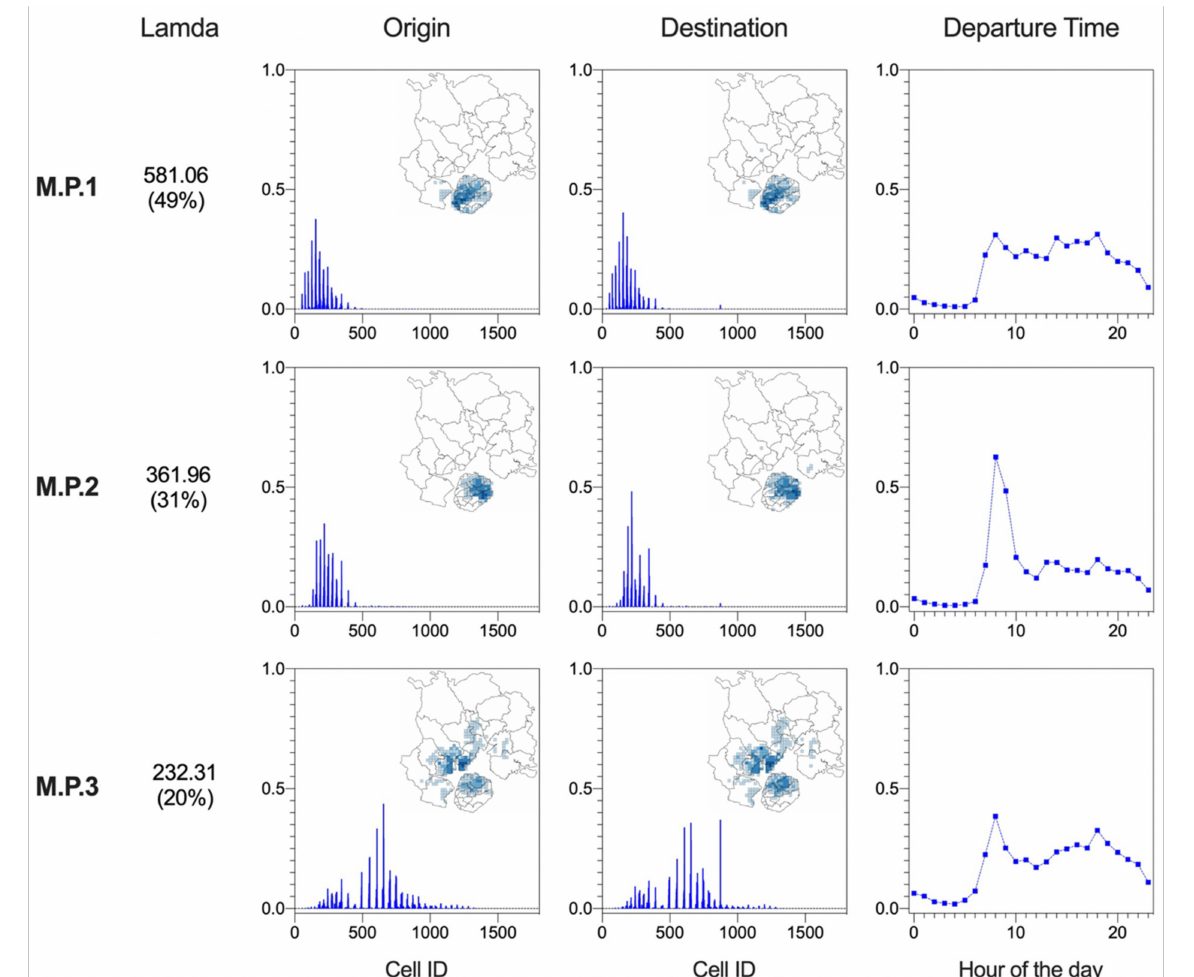
Figure 14. Meta-patterns of ride-hailing mobilities on weekdays. On weekends, morning peaks seldom occur. However, increases in travel in the afternoon are observable for both taxi (Figure 15) and ride-hailing (Figure 16). Moreover, taxis remain the major supplier of late-night mobility within the island (Figure 15, M.P.1), with origins centered at leisure places. Alternatively, the temporal fluctuations of all other meta-patterns are relatively paralleled, suggesting that travels to and from weekend activi- ties by different means share similar schedules, all starting to grow at 8:00 and reaching a peak at around 18:00. The service ranges of ride-hailing do not change significantly from weekdays to weekends; all are combined to cover the island and cross-strait hotspots. However, the daytime meta-patterns of taxis become fuzzier in terms of spatial distribution and movements, showing no obvious functional orientations. Overall, Xiamen is a compact city with a high level of land-use integration. In built-up areas, especially on the island, working and leisure activities cannot be clearly separated in the narrow